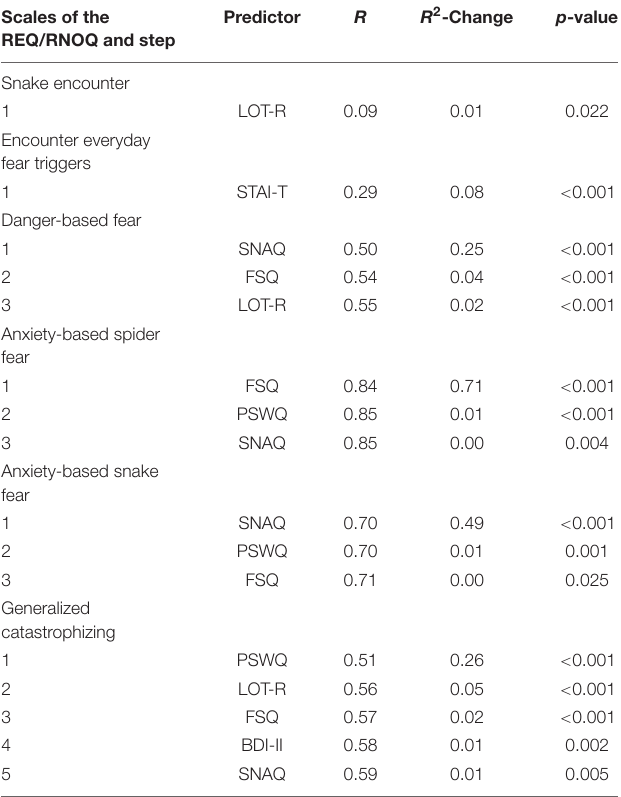
accounted for the best model fit: F (3,626) = 539.44, p < 0.001, corrected R 2 = 0.72. For “anxiety-based snake fear,” predictors were the same; however, with a different order: fear of snakes, β = 0.54,